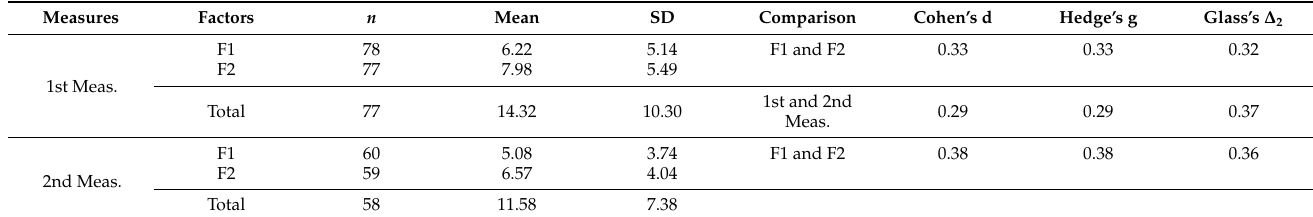
Table 6. Effect size between BAI factors. First